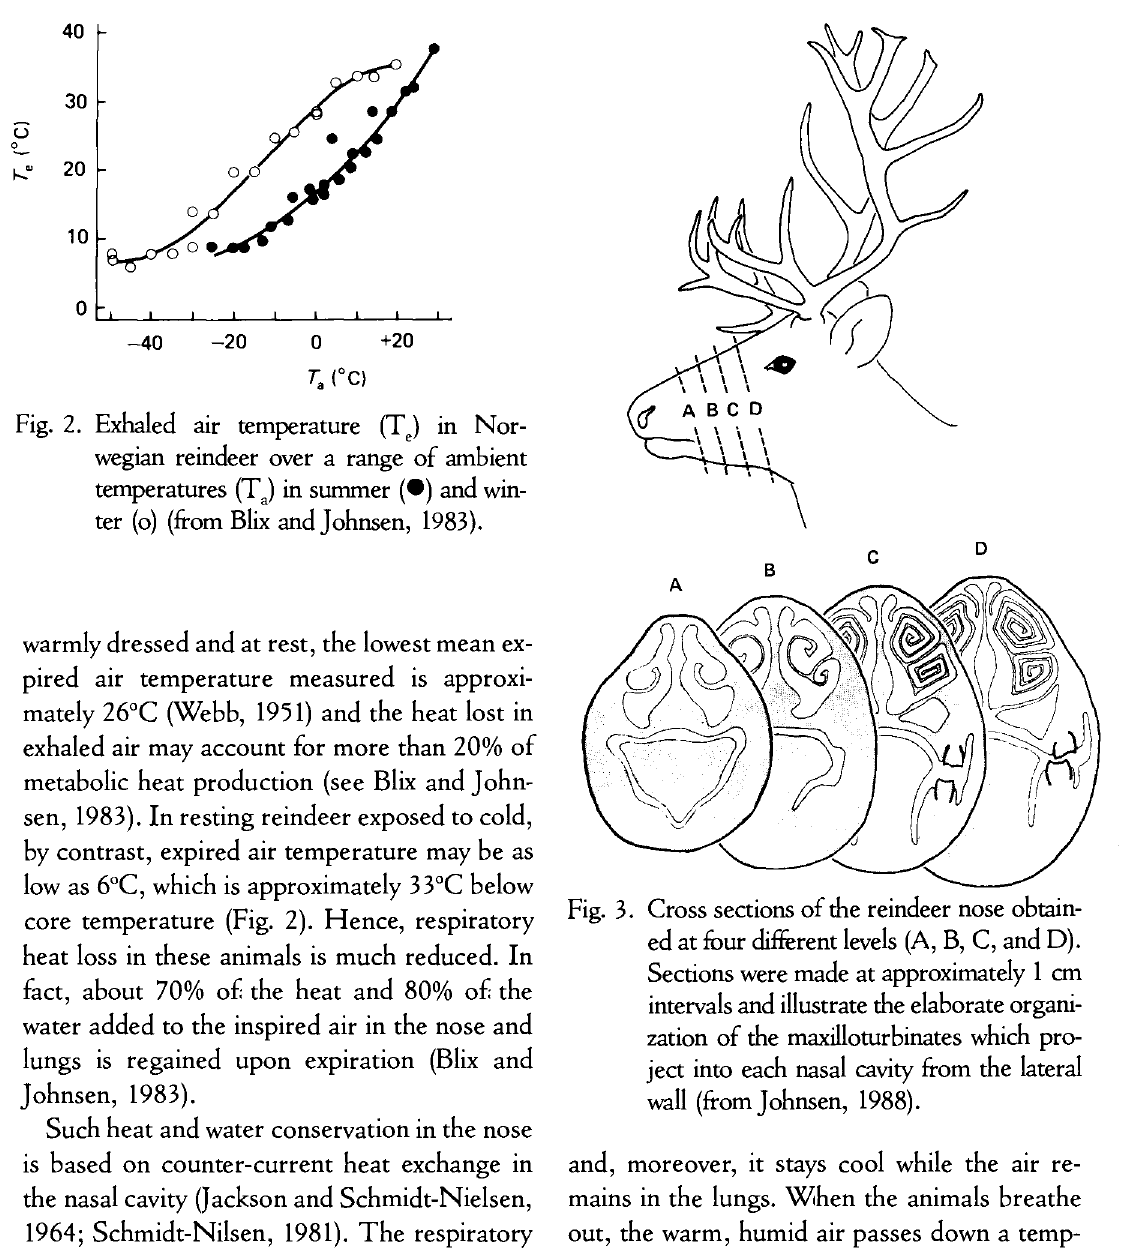
Fig. 3. Cross sections of the reindeer nose obtain ed at four different levels (A, B, C, and